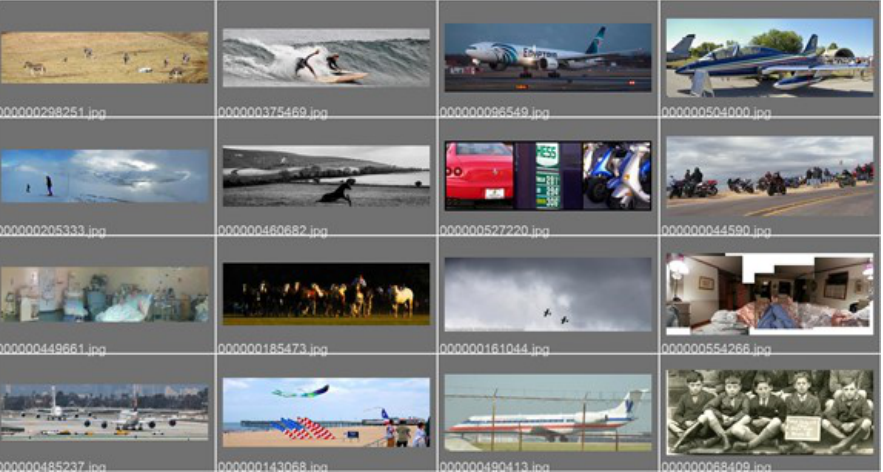
Figure 10. Examples of annotated images in the test set from the COCO and SEAGULL combination— the pretrained algorithm failed to predict bounding boxes in all test